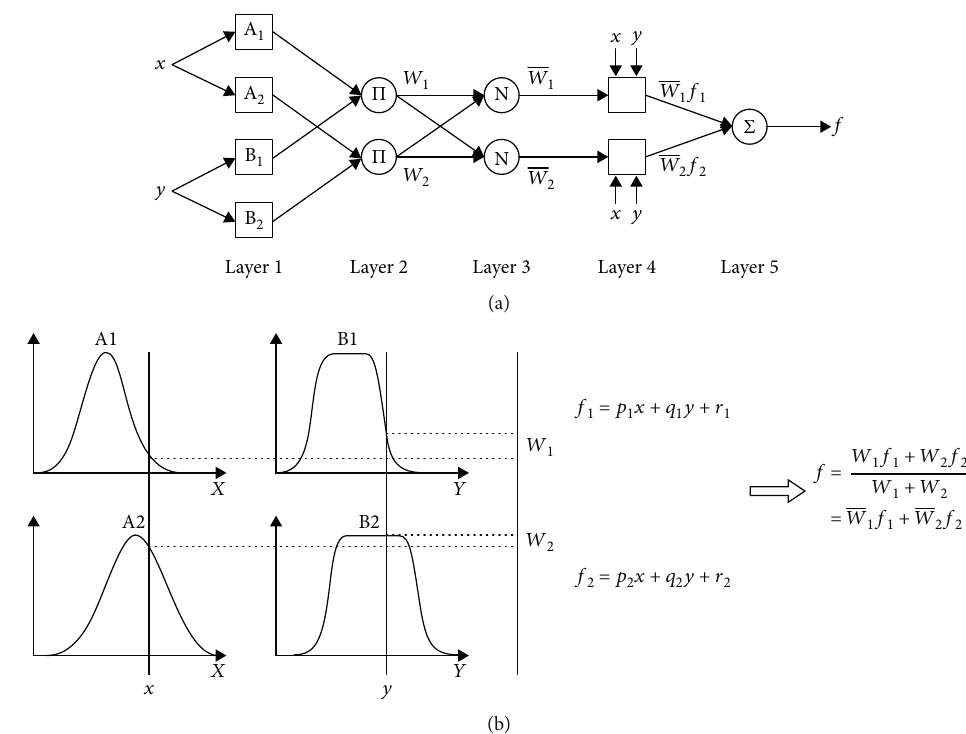
Figure 2: The basic equivalent architecture of ANFIS (a) two-input fi rst-order (b) Sugeno fuzzy model with two